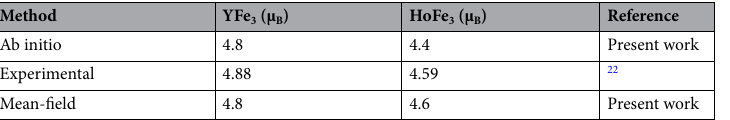
Table 1. Magnetic moments at very low temperature (~ 0 K) using our calculation, in comparison to experimental data.